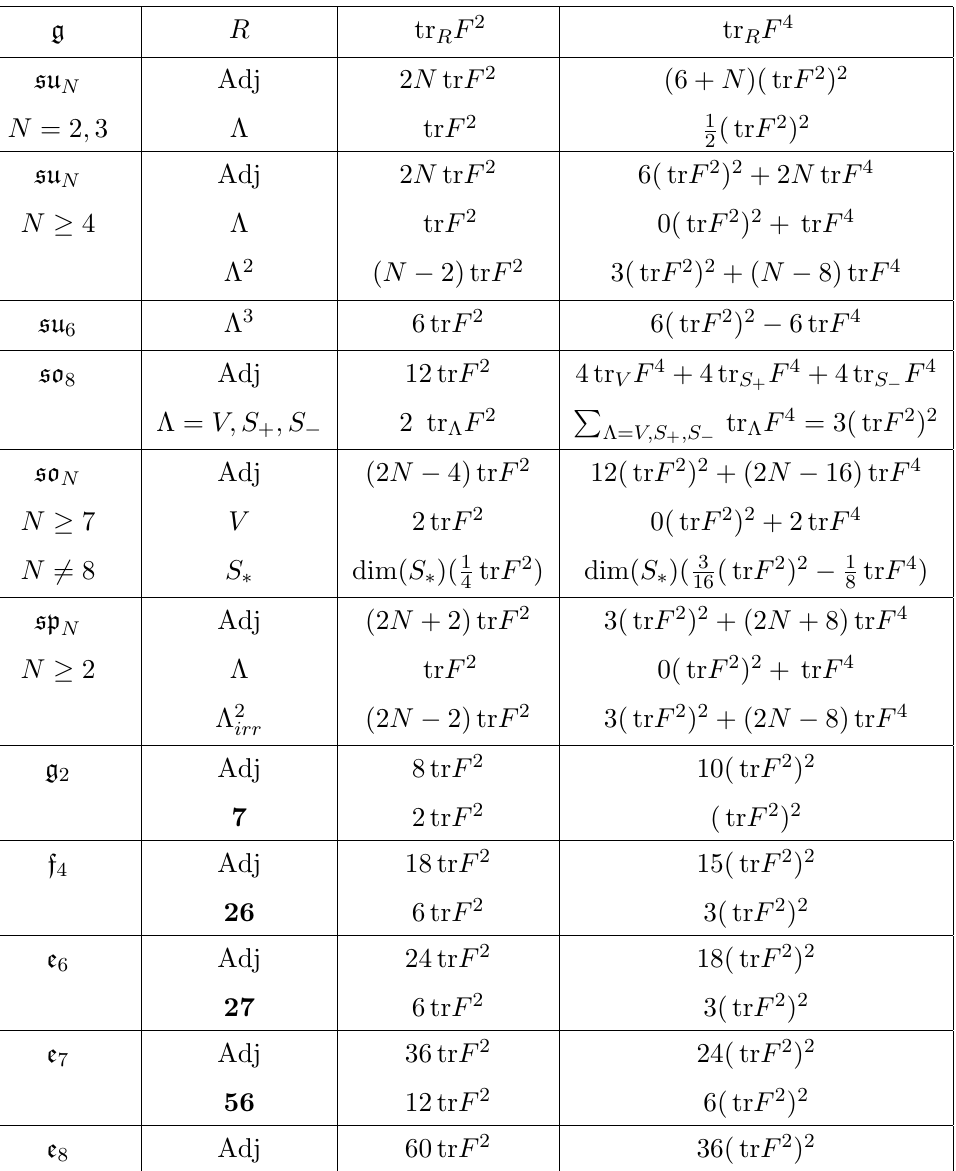
Table 4. Anomaly coe(cid:14)cients in our normalization [130,